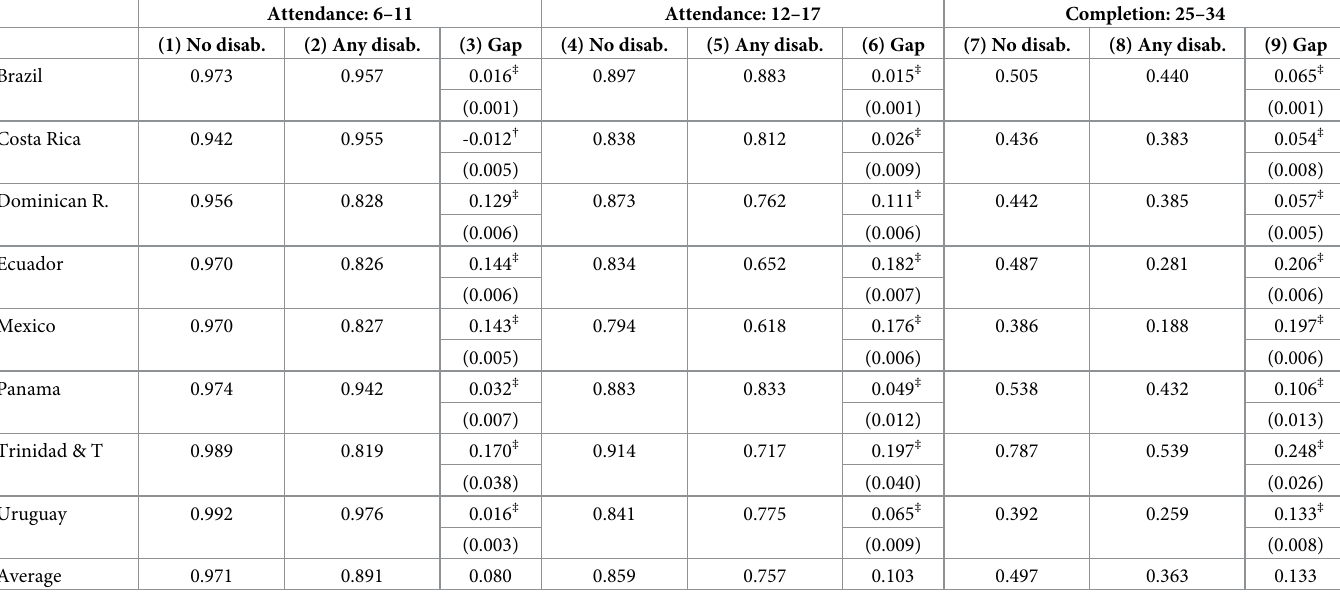
Table 4. Estimates for school attendance and completion rates and